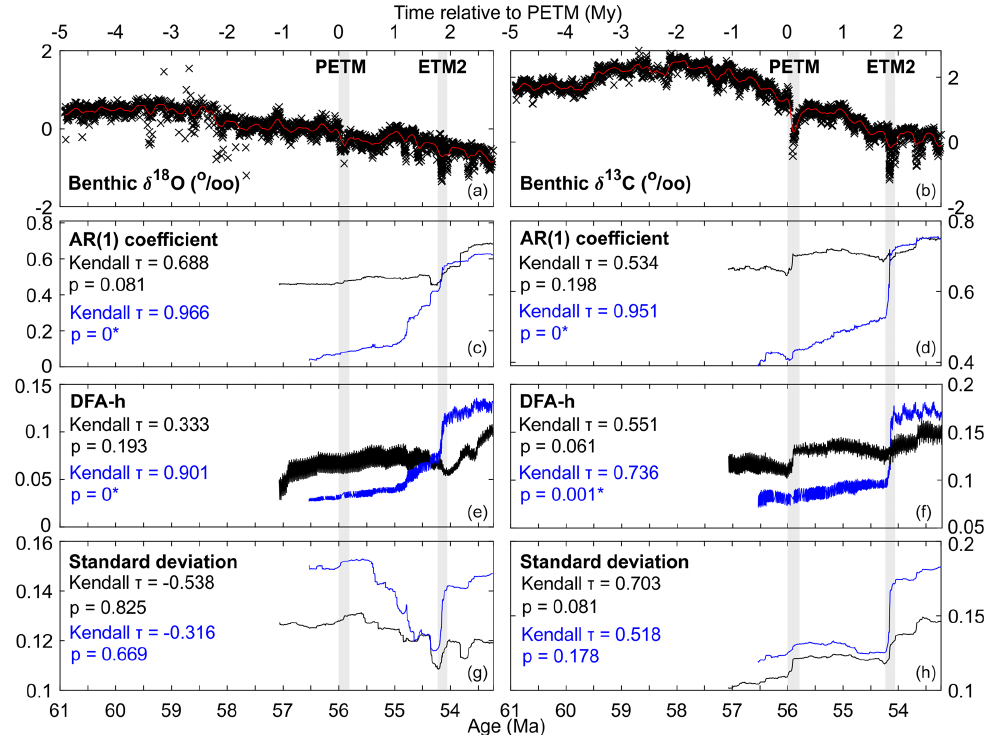
Figure 3. Rolling window resilience analysis of benthic δ 18 O (a) , (c) , (e) , (g) and δ 13 C (b) , (d) , (f) , (h) across the PETM and ETM2. Panels (a) and (b) illustrate the palaeorecords (black crosses) and the smoothed record used to detrend the data (red line), with the panels below illustrating the results of the analysis for (c, d) AR(1) coefficient, (e, f) detrended fluctuation analysis h value, and (g, h) standard deviation calculated in a 50% rolling window across each time series for both interpolated (black line) and non-interpolated (blue line) data with the Kendall τ rank correlation and bootstrapped p value for each. The PETM and ETM2 are marked by the grey bars. Results for skewness, kurtosis, and sensitivity analyses for all metrics can be found in the